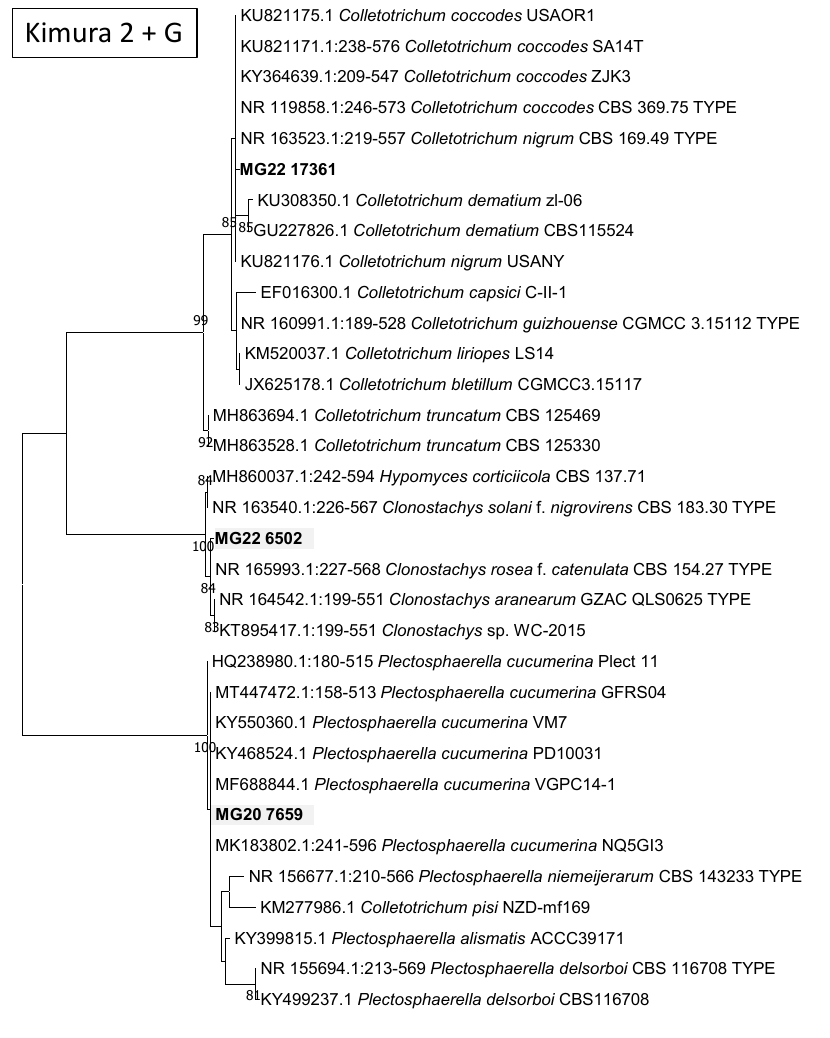
Figure 5. Phylograms of Molecular Operational Taxonomic Units. A Ustilago (A). B Rhizoctonia . The phylograms were generated with Maximum Likelihood analyses of the Internal Transcribed Spacer 2 region (used evolutionary model indicated). Confidence levels ≥ 80% (1000 replicate bootstrap analysis) are indicated on the branches. Sequence reads generated in this study are indicated with MG codes.